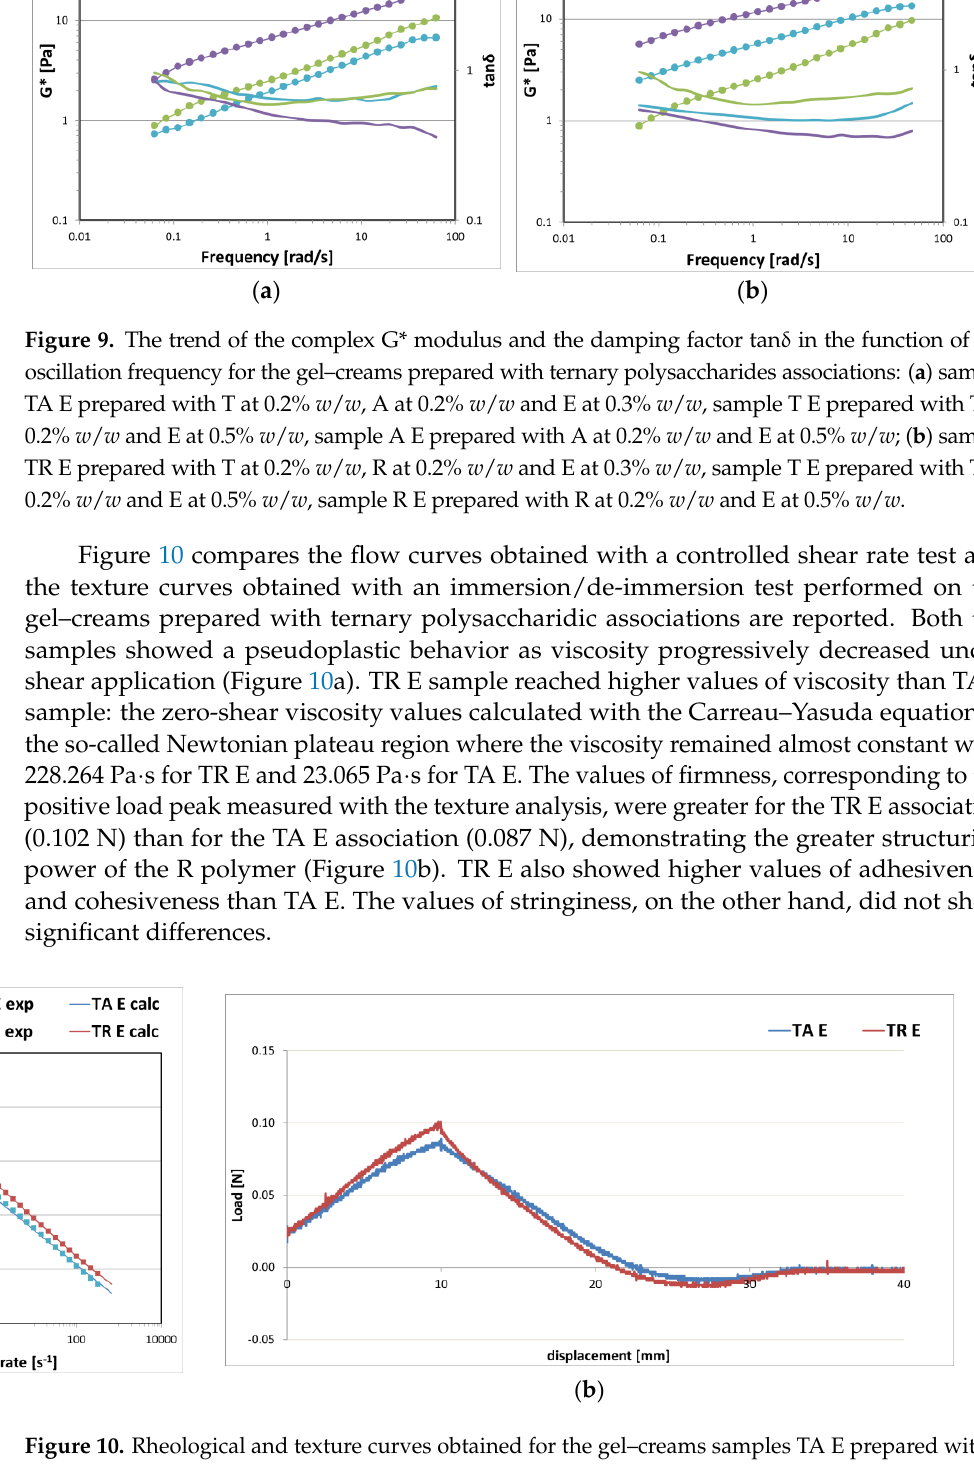
( b ) Figure 8. Texture and rheological parameters measured before and after adding 3% w / w of PFP for the gel – creams T E prepared with T at 0.2% w / w and E at 0.5% w / w , A E prepared with A at 0.2% w / w and E at 0.5% w / w , R E prepared with R at 0.2% w / w and E at 0.5% w / w : ( a ) damping factor tanδ at 1.5 Hz obtained from the frequency sweep analysis and ( b ) firmness obtained from the texture analysis. Keeping the total amount of polymer concentration fixed at 0.7% w / w we prepared samples by using a ternary mixture of the polysaccharides in order to obtain the best fit in terms of stability of the product, sensorial and mucoadhesive properties. E (C18-C22 hydroxyalkyl hydroxypropyl guar gum) is the emulsifier polymer that allows creating the product’s structure, T ( tamarind seed polysaccharide) is the polymer that can guarantee mucoadhesion, while A (sclerotium gum) or R (succinoglycan gum) are two polymers that can optimize the stability of the product conferring elasticity to the bulk structure. In Fig-